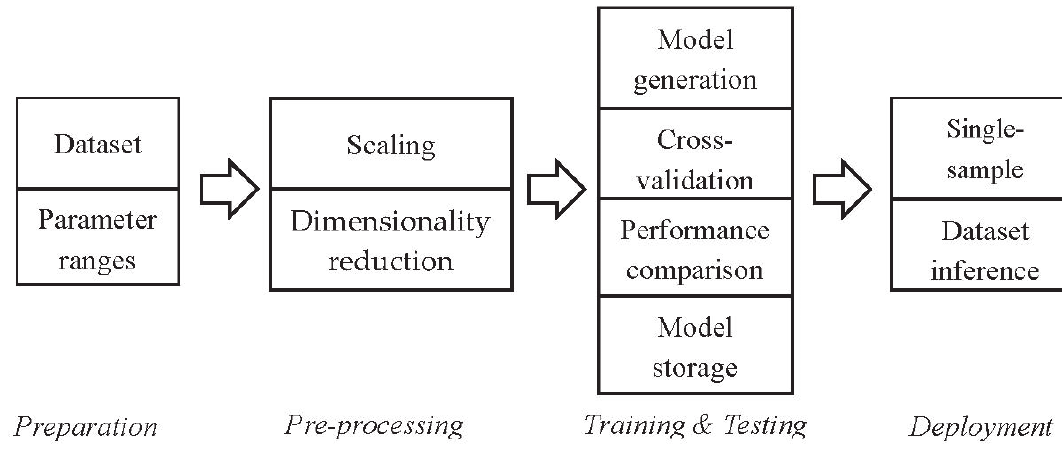
Figure 2. Supported workflow.